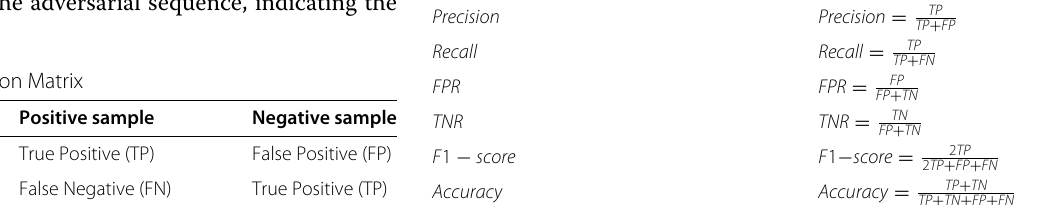
The ROC curve (Fawcett 2006) calculates the TPR and FPR of the model according to the classification threshold, and then draws the curve with TPR as the vertical coordi- nate and FPR as the horizontal coordinate. The larger the FPR is, the more the actual negative samples are in the pre- dicted positive class. In addition, the larger the TPR is, the more the real positive examples are in the predicted pos- itive class. In general, the area under the curve (AUC) of the ROC curve is used to evaluate a classifier directly. The characteristic of the ROC curve is very stable. When the distribution of positive and negative samples in the test set changes, the ROC curve can remain unchanged. Thus, it is suitable to evaluate the uneven data.